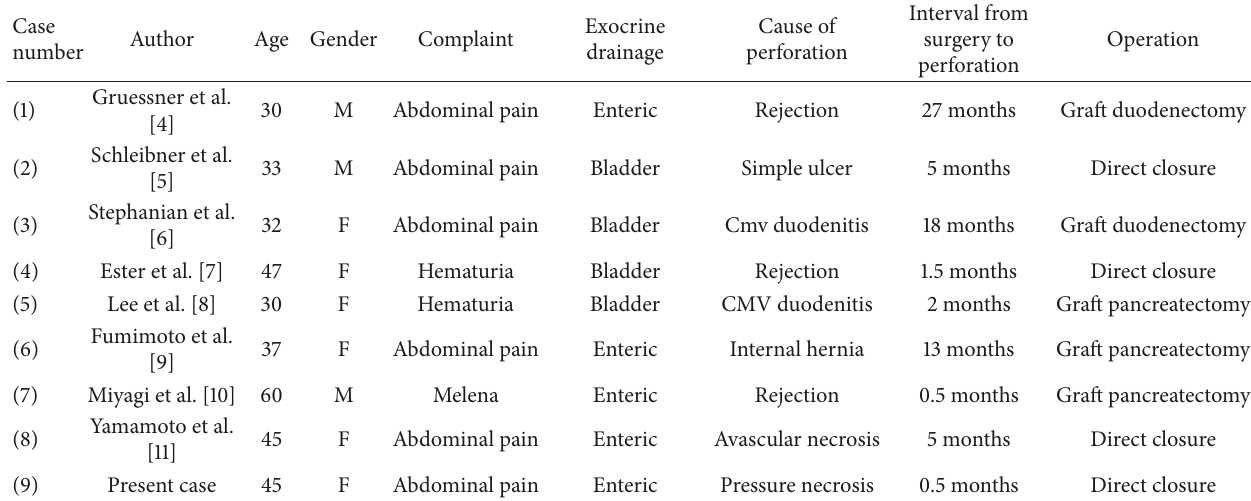
Table 1: Reported cases of donor duodenal perforation after pancreatic transplantation. Pancreatic graft preservation was possible in six patients, including our